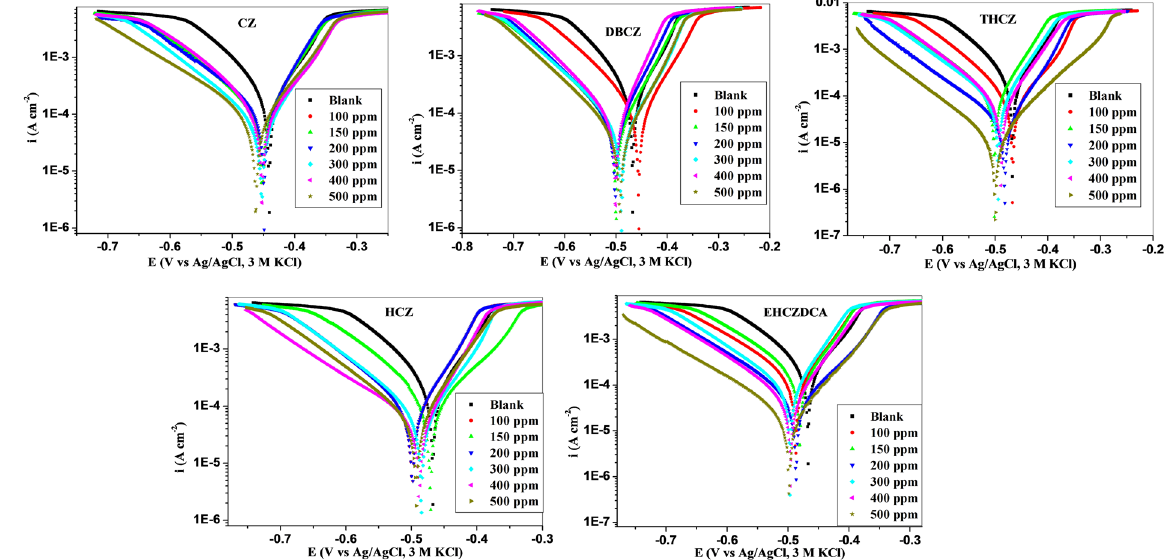
Figure 1. Polarization curves for mild steel in absence and presence of different concentrations of